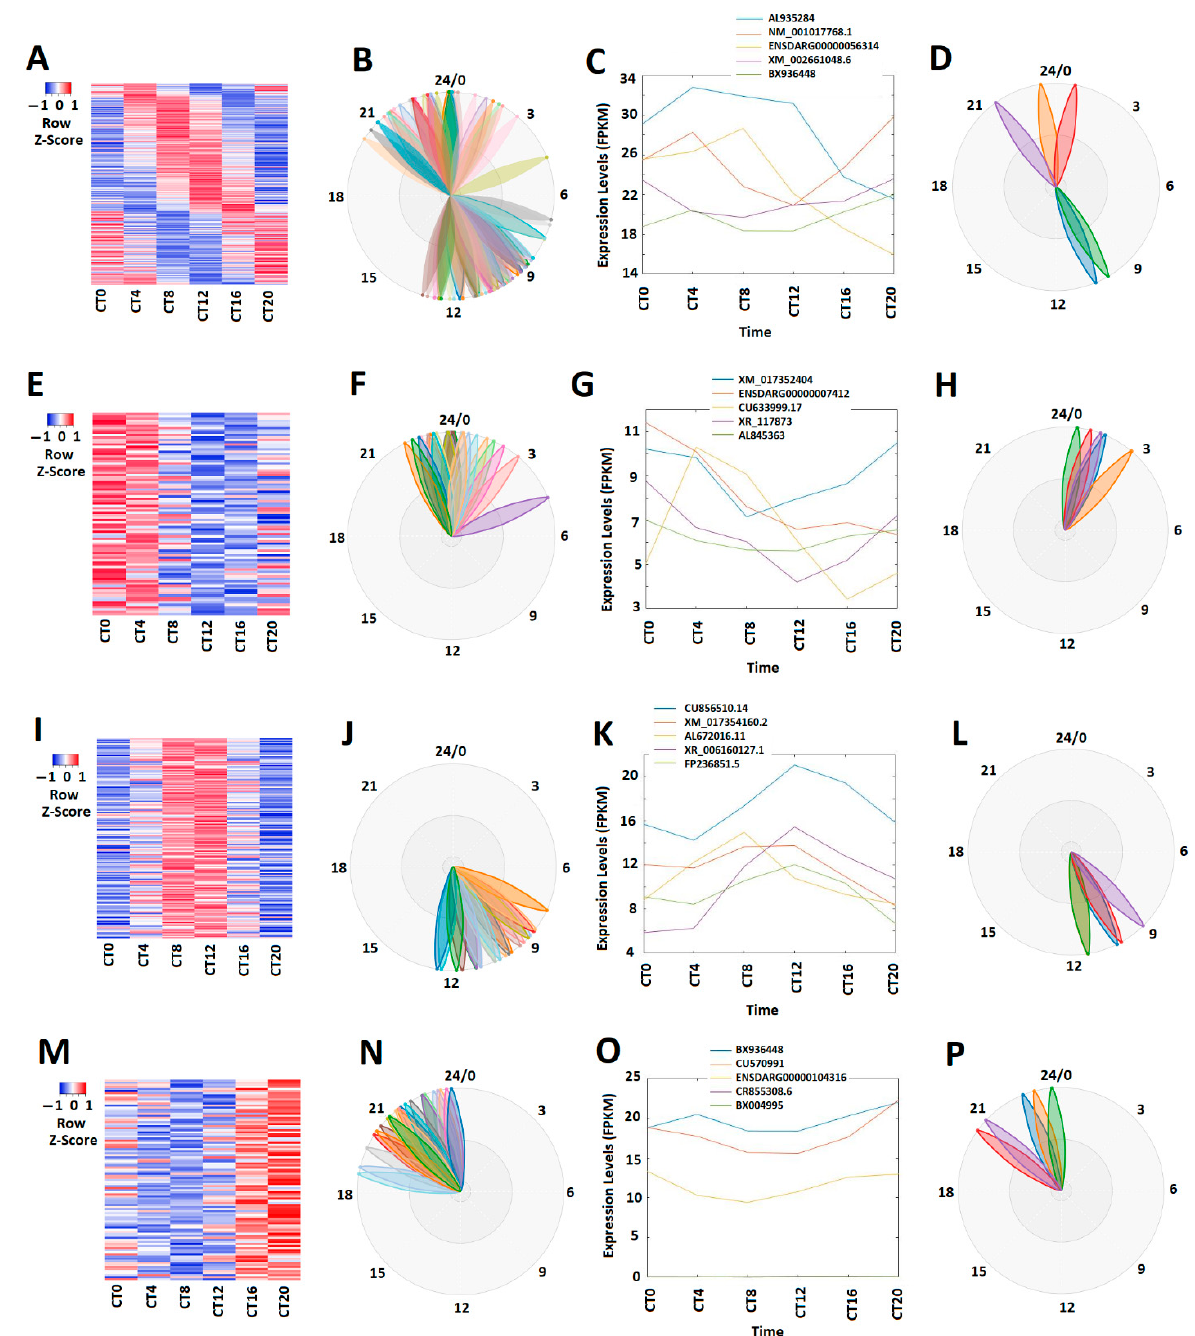
Figure 3. Expression profile analysis circadianly expressed zebrafish larval lncRNAs under the LL condition. ( A – D ) Analysis of all the 309 circadianly expressed larval lncRNAs under the DD condition. Heat map ( A ) and BioDare2 plots ( B ) of all 309 the circadianly expressed larval lncRNAs, expression profiles ( C ) and BioDare2 plots ( D ) of representative lncRNAs. ( E – H ) Analysis of the 78 larval morning (CT0 and CT4) lncRNAs. Heat map ( E ) and BioDare2 plots ( F ) of the 78 larval morning lncRNAs, expression profiles ( G ) and BioDare2 plots ( H ) of larval morning representative lncRNAs. ( I – L ) Analysis of 144 larval evening (CT8 and CT12) lncRNAs. Heat map ( I ) and BioDare2 plots ( J ) of 144 larval evening lncRNAs, expression profiles ( K ) and BioDare2 plots ( L ) of larval evening representative lncRNAs. ( M – P ) Analysis of 87 larval night (CT16 and CT20) lncRNAs. Heat map ( M ) and BioDare2 plots ( N ) of 87 larval night lncRNAs, expression profiles ( O ) and BioDare2 plots ( P ) of larval night representative lncRNAs.